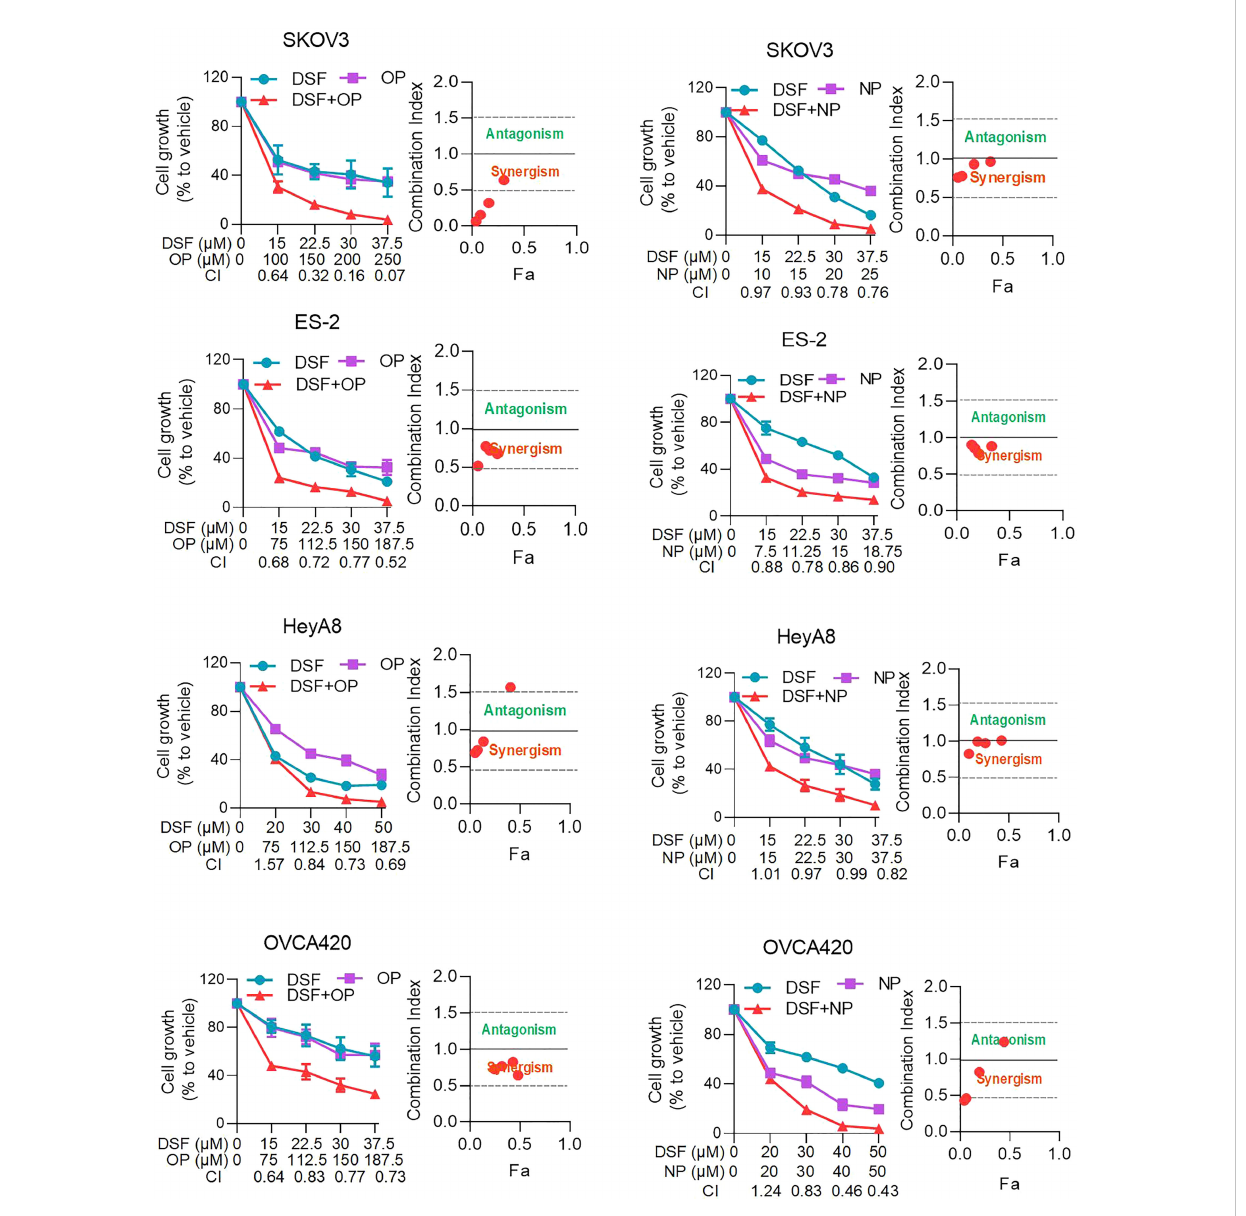
FIGURE 2 Effect of Disul fi ram in combination with and Olaparib and Niraparib on ovarian cancer cell growth. The right column shows the plots of proliferation after treatment with Niraparib and Disul fi ram in SKOV3, ES-2, HeyA8, and OVCA420 cell lines. The left column shows the plots of proliferation after treatment with Olaparib and Disul fi ram in the SKOV3, ES-2, HeyA8, and OVCA420 cell lines, respectively. The plot of the CI vs inhibition rate (Fraction affected, Fa) of each case are shown next to the columns. Dot falls on red “ Synergism ” indicate a CI below one, and green “ Antagonism ” indicated a CI above one. Data are represented as mean ± SD (n=4 per